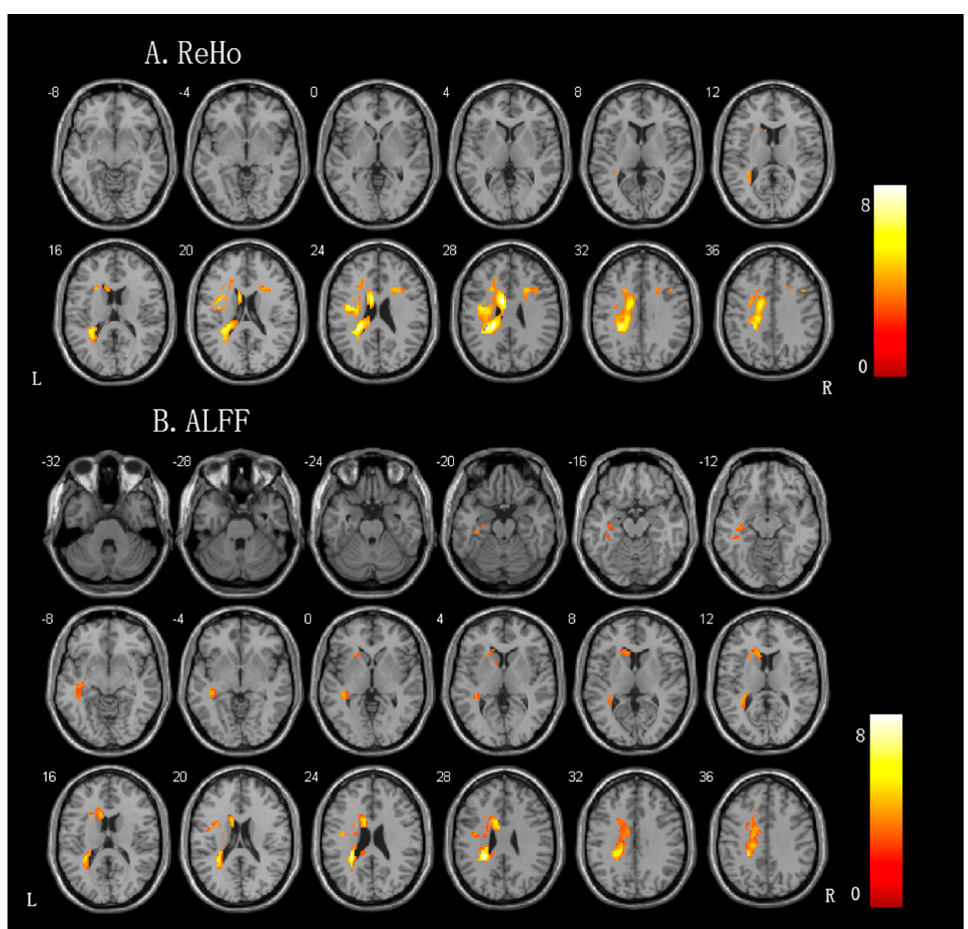
Figure 2. Brain regions showing significant differences in the spontaneous brain activity between the patients with aphasia and controls. ( A ) ReHo (regional homogeneity) value. ( B ) ALFF (amplitudes of low-frequency fluctuation) value. Table 3. The ReHo and ALFF values were increased in the patients with aphasia compared to those in the healthy controls.